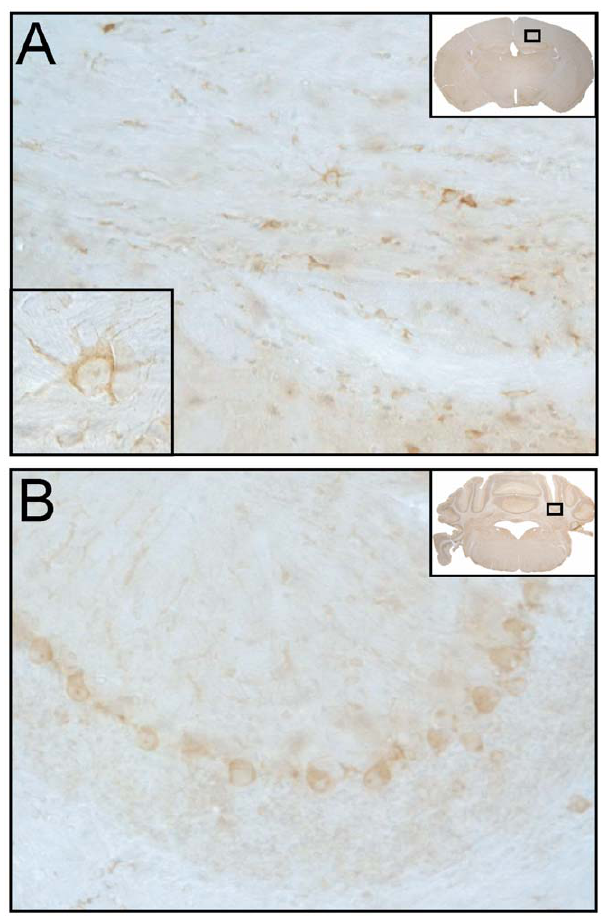
Figure 2. Representative micrographs of a non infected control animal. A: Corpus callosum (bregma -2); B: Cerebellum (bregma -6). Positive immunolabeling for Nogo-A was observed in cells showing morphological characteristics of oligodendrocytes (figure 2A) and neurons (figure 2B). Framed areas in the respective inserts delineate regions of interest presented in the micrographs. Magnifications: A: 20x, left inlay 100x; B: 20x.